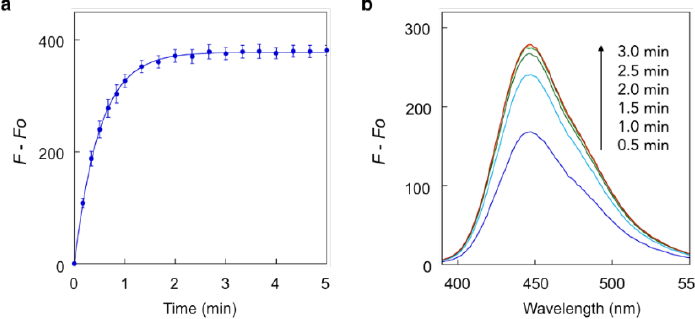
Figure 2. Fluorescence analysis of spontaneous degradation of 5 . ( a ) Time-trace plot of the fluorescence intensity of 1 (λ em = 450 nm) released from 5 . ( b ) Fluorescence spectral change of 5 . Measurements were conducted at 0.5, 1, 1.5, 2, 2.5, and 3 min after addition of 5 into the neutral buffer solution. Measurement conditions: ( 5 ) = 5 μM, 50 mM HEPES, pH 7.4, 37 °C, λ ex = 320 nm.